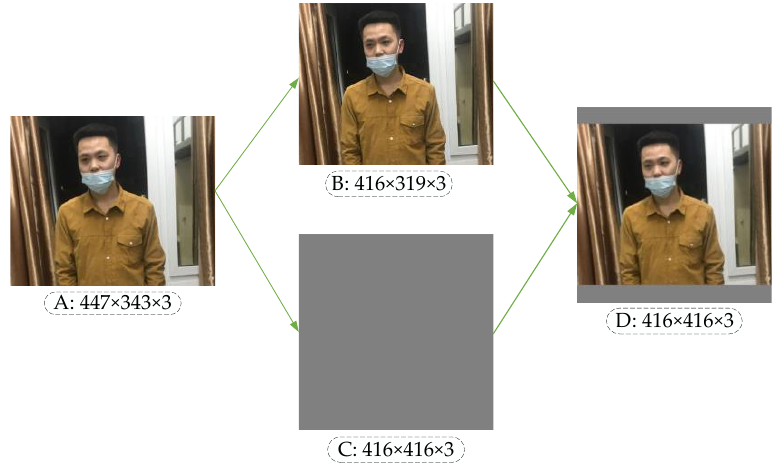
Figure 6. Image scaling in YOLO-v4.